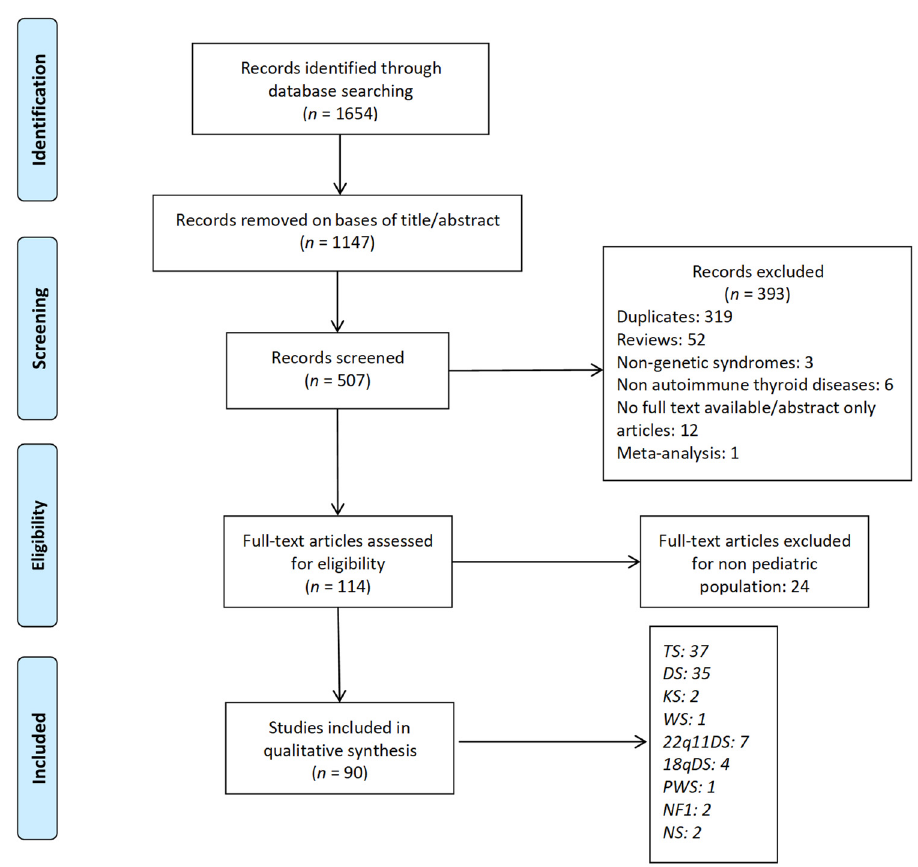
Figure 1. Flow diagram summarizing study selection process. One article [111] is shared by DS and TS. TS: Turner syndrome; DS: Down syndrome; KS: Klinefelter syndrome; 22q11DS: 22q11.2 deletion syndrome; PWS: Prader-Willi syndrome; WS: Williams syndrome; NF1: neurofibromatosis type 1; NS: Noonan syndrome.